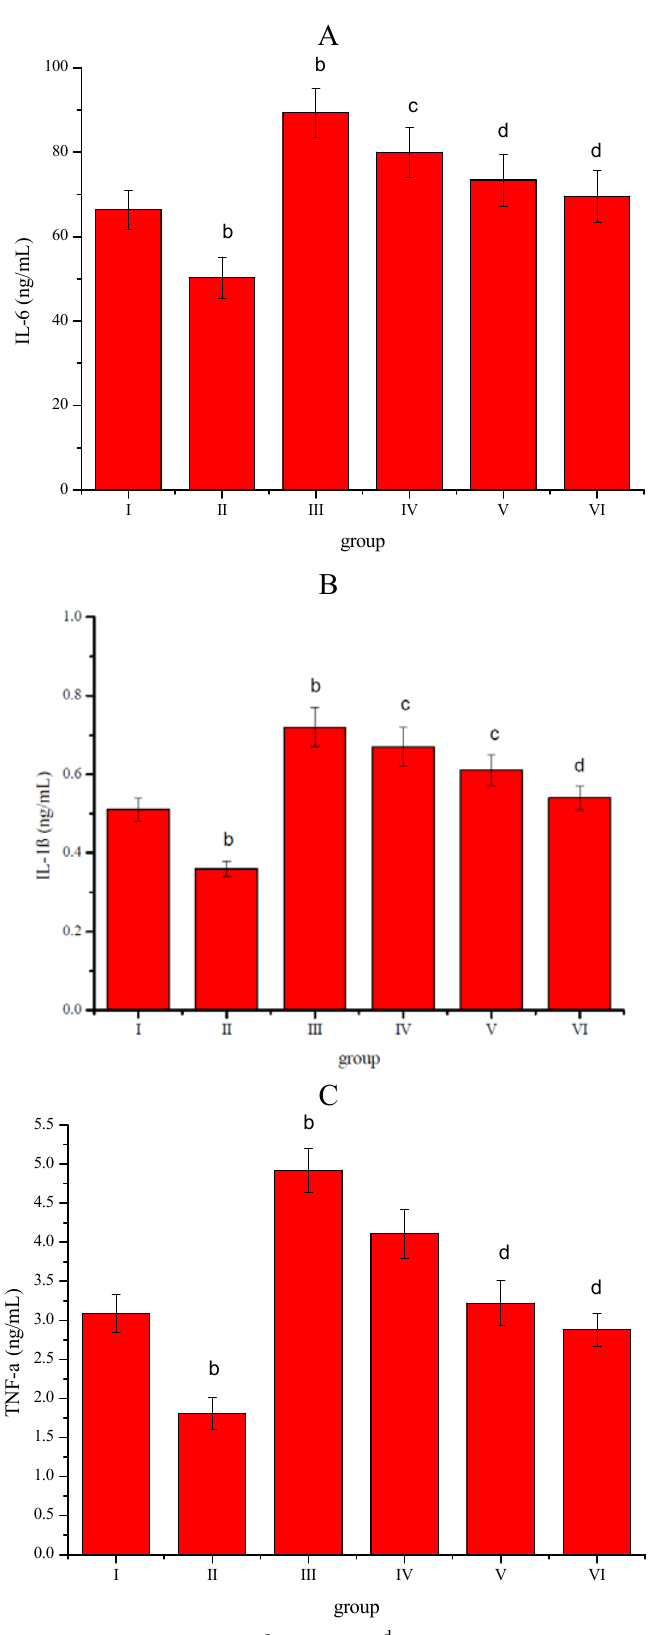
Figure 2. ( A ) Effect of Sargassum pallidum aqueous extract on serum IL-6, ( B ) IL-1 β and ( C ) TNF- α levels in different